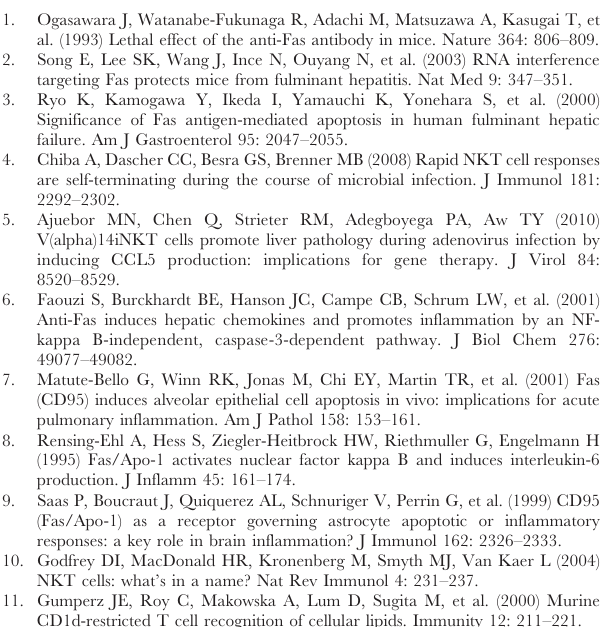
Figure S1 Effect of NAC treatment on intrahepatic V a 14 i NKT cell CD25 expression during agonistic Fas mAb-induced FLF. The number of CD25-expressing V a 14 i NKT cells in the liver after PBS or NAC treatment during Fas mAb-induced FLF at 4.5 h. All experiments were performed twice. Data is presented as mean 6 s.e.m with n= 4 mice/group (Figure S1); * P , 0.05 vs. PBS group (no Fas mAb treatment); * P , 0.05 vs. NAC/Fas mAb-treated group. # P , 0.05 vs PBS group (no Fas mAb treatment); # P , 0.05 vs. PBS/Fas mAb- treated group. Analysis performed by one-way analysis of variance followed by Newman-Kuels post hoc